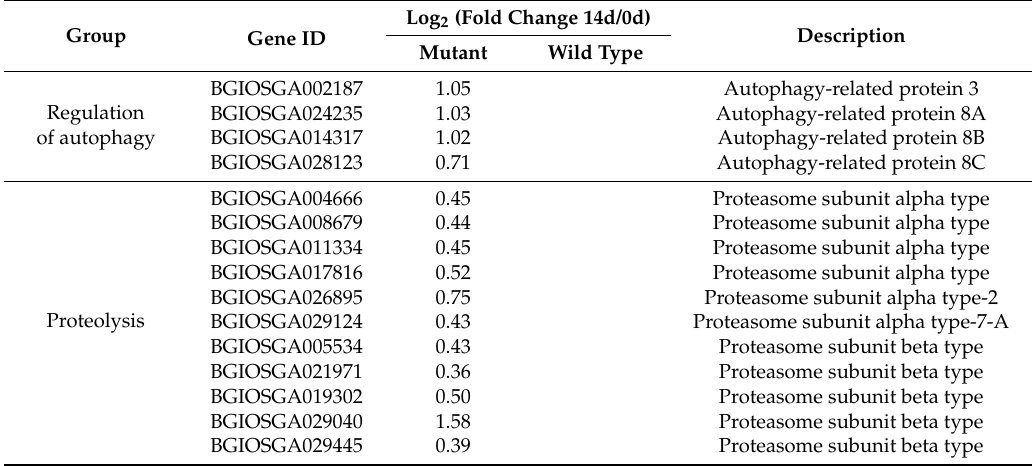
Table 9. Genotypic differences in expressions of DEGs involved in the hydrolysis and autophagy between the initial and 14th day of the grain-filling stage (padj <